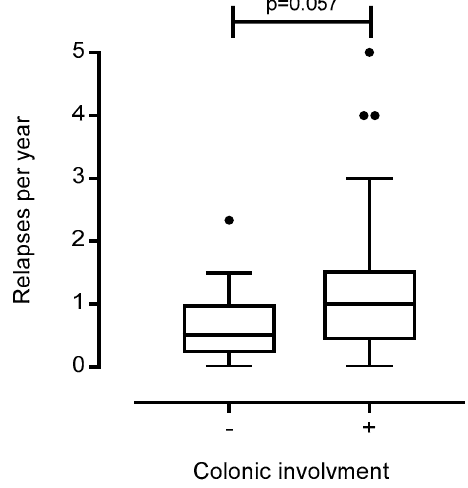
Figure 1. Distribution of relapses per year according to disease location (colonic vs. non-colonic) in children diagnosed with Crohn’s disease (Turkey boxplot (1.5IQR) for outliers). Granuloma positive and negative groups did not di ff er significantly in age, gender or for the presence of extra-intestinal manifestations (EIM), disease behaviour or the presence of perianal